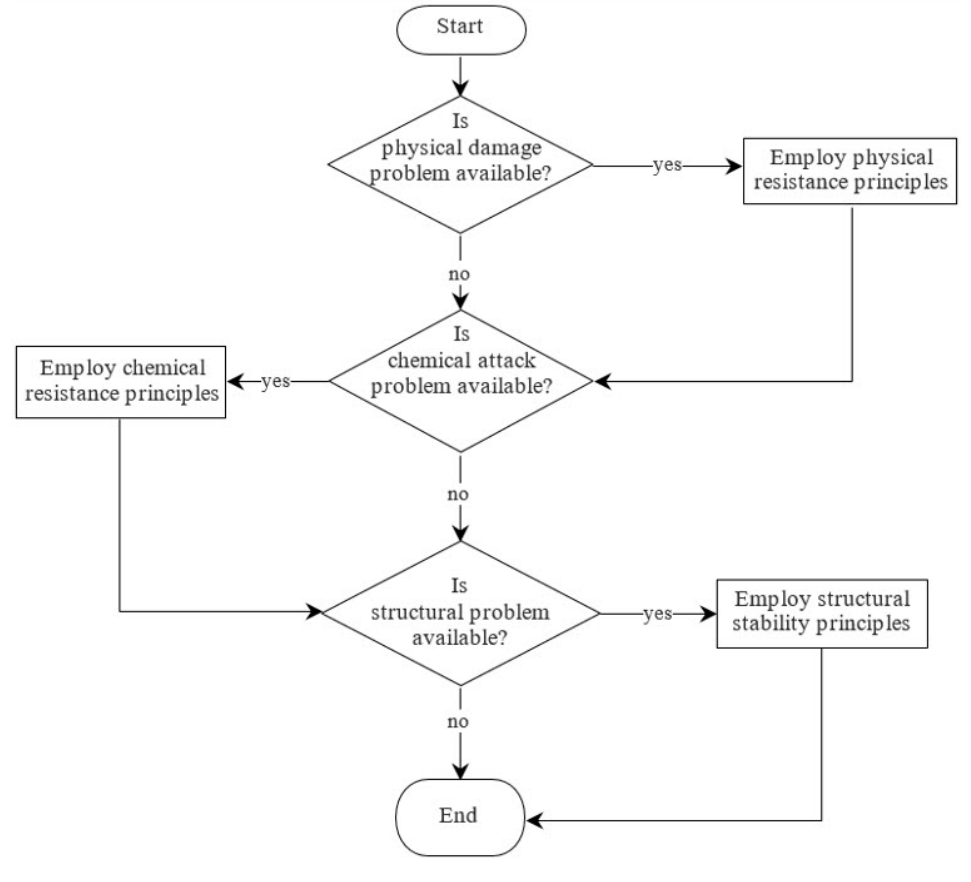
Figure 4. Classification of repairing principles.